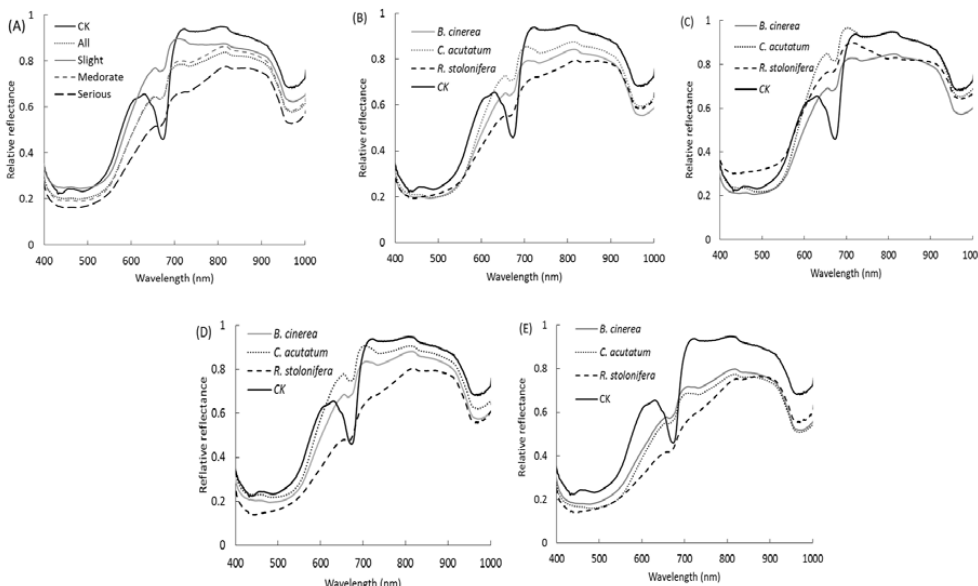
Figure 2. Average reflectance spectra of three kinds of disease and control group using the entire spectral region from 400 to 1000 nm for ( A ) different decay stages of all kinds of diseases, ( B ) different kinds of diseases of all decay stages, ( C ) slightly-decayed samples of different diseases, ( D ) moderately-decayed samples, ( E ) severely-decayed samples.